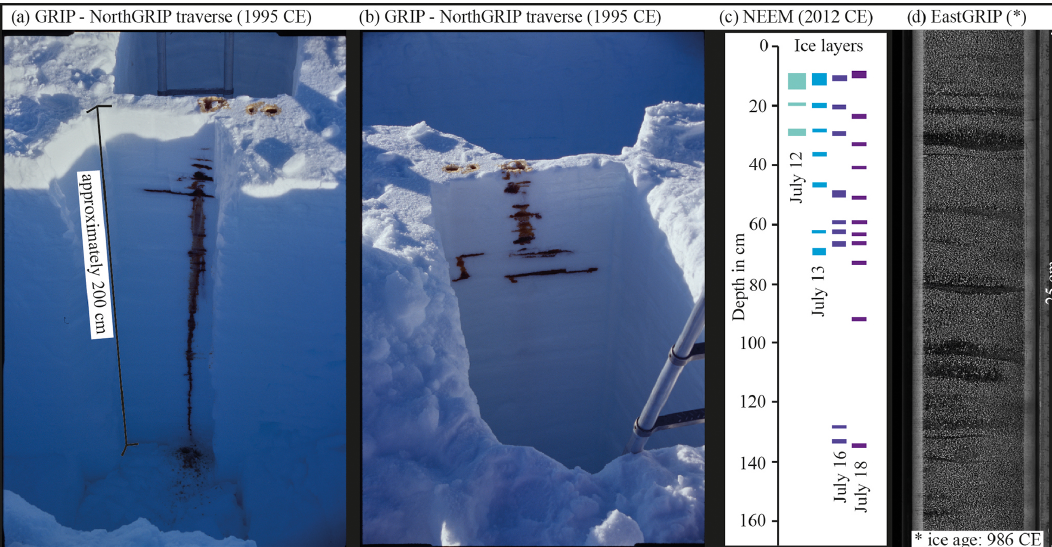
Figure A1. (a, b) Two sides of the same double trench, with three coffee injection points visible on the surface of the trench wall. Vertical coffee pipes are not always visible, but the horizontal coffee layers and lenses are very pronounced. The long vertical pipe reaching the bottom in (a) is due to the ex-filtration of coffee from the trench wall. The second trench, shown in (b) , was dug after coffee injection. The trench’s depth was approximately 2m. (c) Appearance of ice layers at different depths during the warm event in 2012CE at NEEM. Measurements were made by extending the same snow pit, which was revisited over the days of the warm event. (d) Upper half of a line scan of bag 252 (top at 138.05m depth, years 986 to 989CE) with multiple melt lenses and